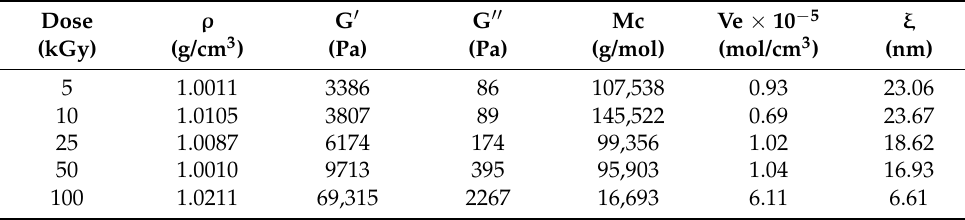
Table 1. The effect of absorbed dose on network parameters of collagen